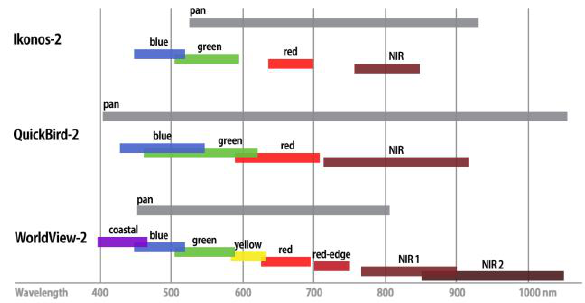
Figure 1. Spectral interval of Ikonos-2, QuickBird-2 and WorldView-2 multispectral and panchromatic bands.